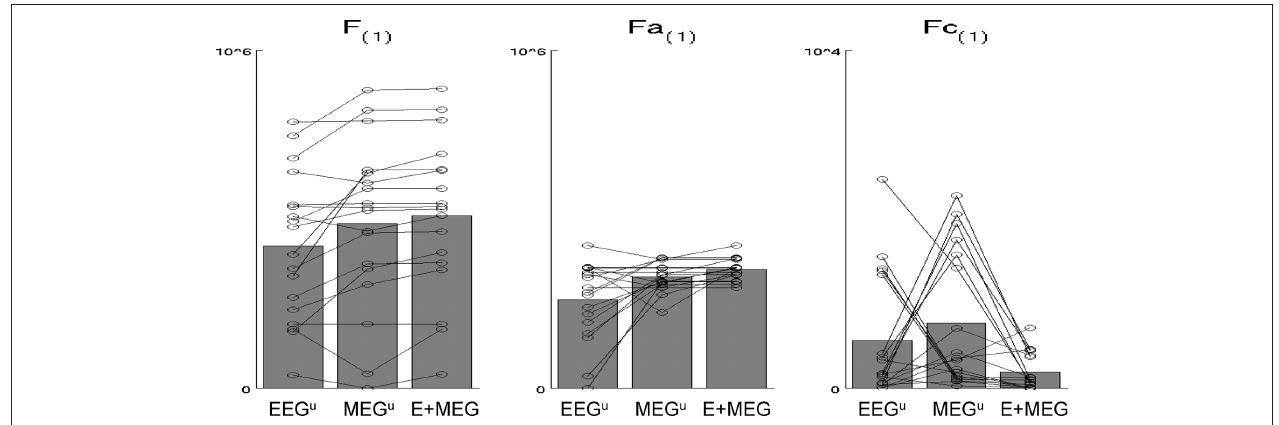
a high mean and precision for the other modality, which effectively discounts data of that modality as noise (see text). The circles joined by lines show the results for each individual subject. The middle and rightmost plots show the two parts of the free-energy: the accuracy ( F ) and the model complexity ( F ); see text for details a c (note that these differ by constant terms that not included here). The advantage of EEG and MEG fusion is reflected by the increase in F and F and decrease in F a c